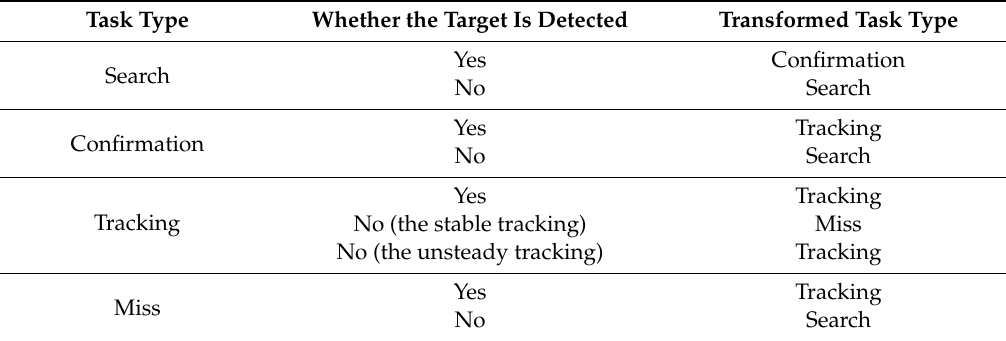
Table 1. The specific transformation of task